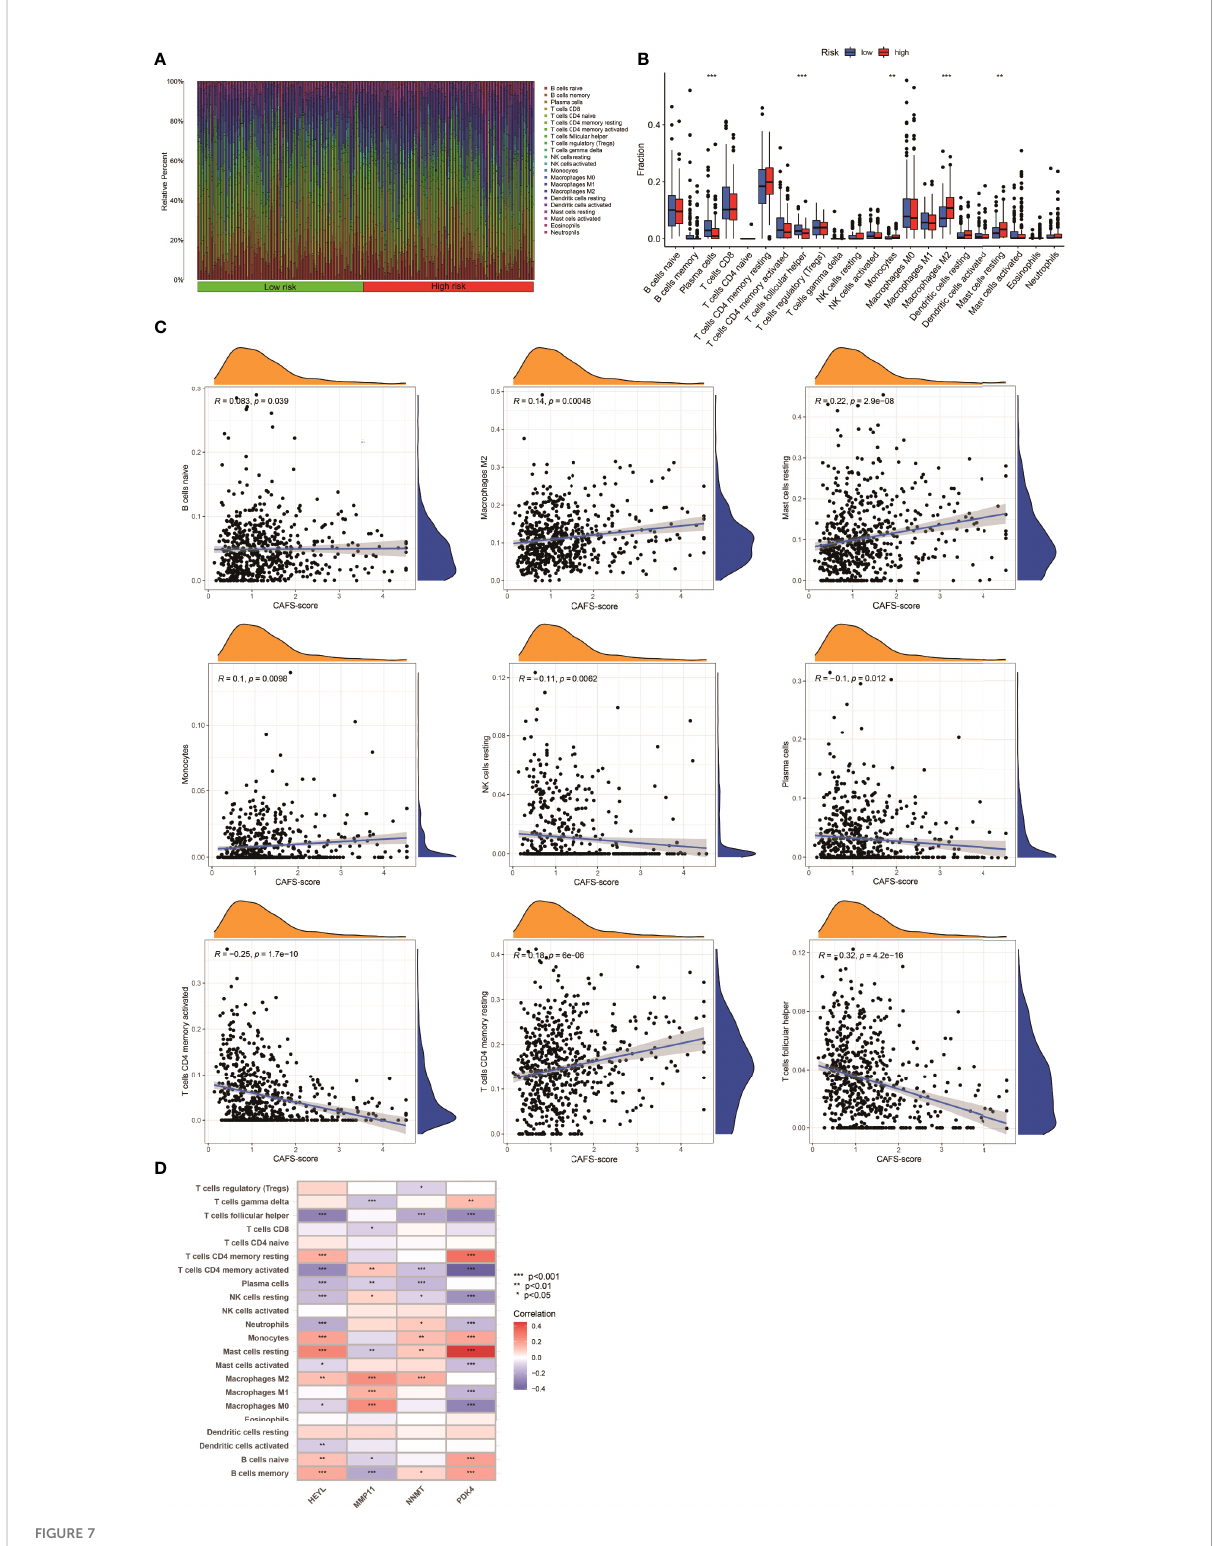
FIGURE 7 Immune In fi ltration in two CAFS-score subgroup (TCGA). (A) Composition of immune cells in two CAFS-score subgroup. (B) The Relative immune in fi ltration score of 22 immune cells between low- and high-risk groups. (C) Relationships between CAFS-score and different immune cells. (D) Correlations between the abundance of immune cells and four genes in the proposed model. *P<0.05, **P<0.01,